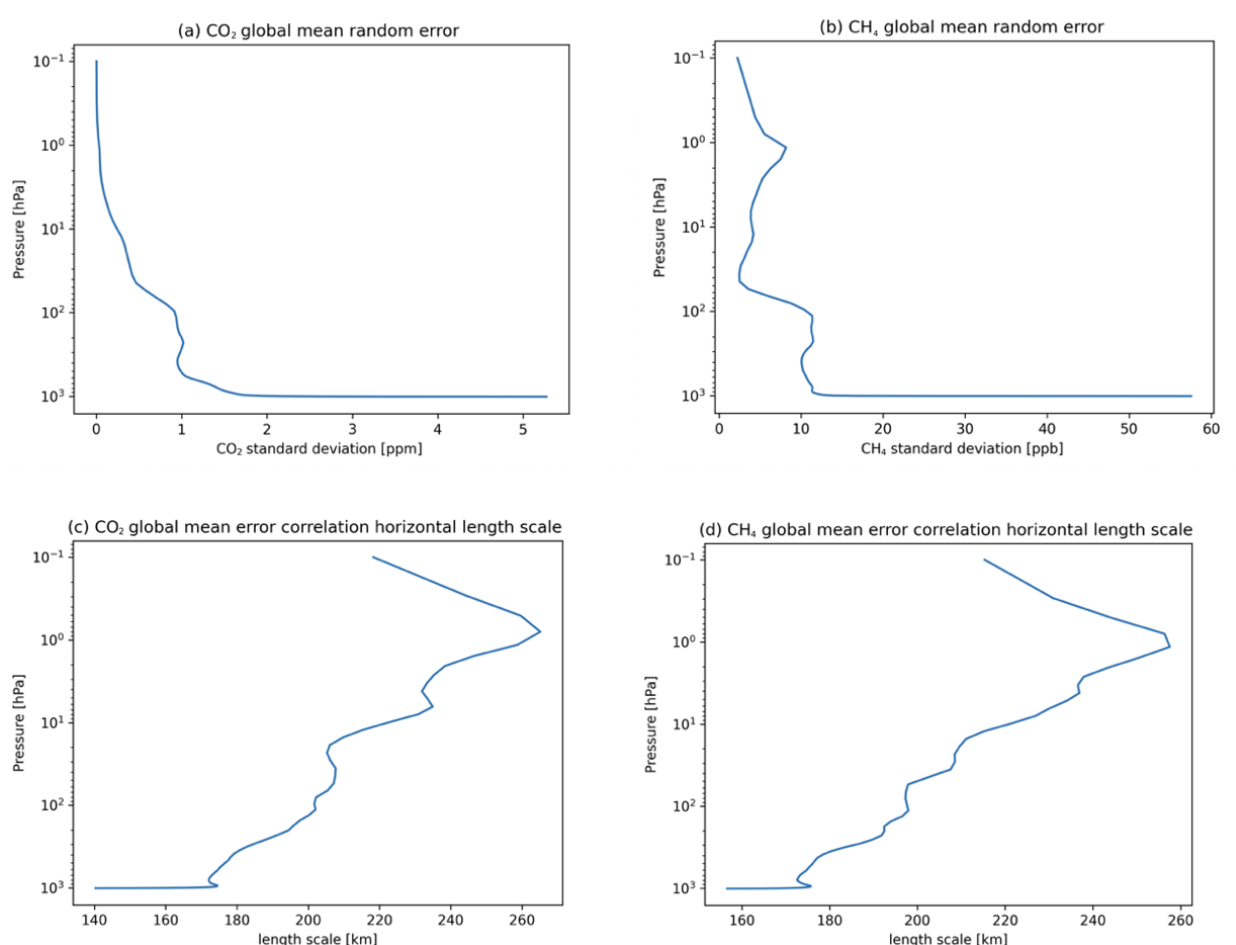
Figure 4. Model background error for CO 2 and CH 4 used in the CAMS GHG reanalysis: (a, b) global mean standard deviation and (c, d) global mean error correlation length scale across the vertical